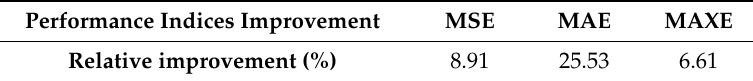
Table 2. Relative performance improvement of the SMO-based estimator over the phasor diagram based estimator during dynamic disturbances of reactive power for generator operating point P = 0.89, Q = 0.41 ind.